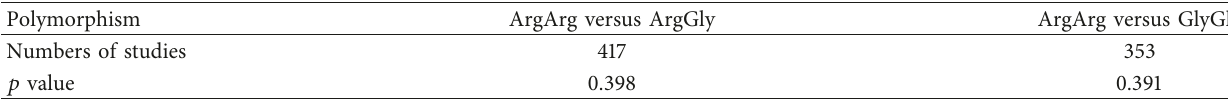
Table 2: Egger’s test.